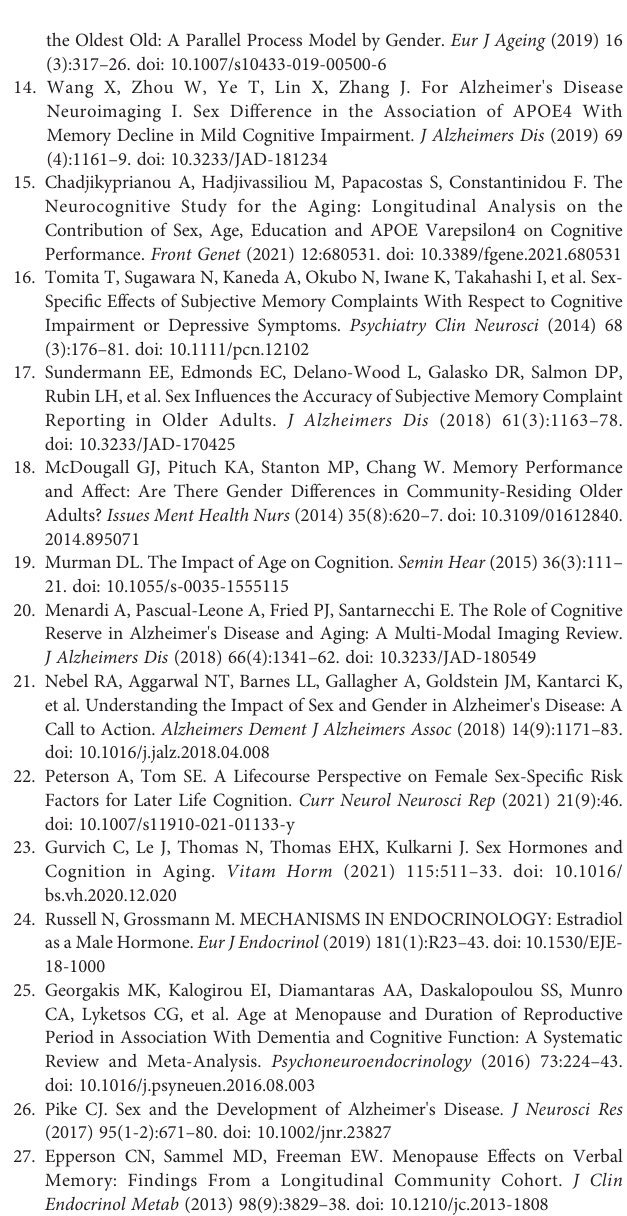
andreproductive yearsand menbyusingoneofthe groupsofwomen